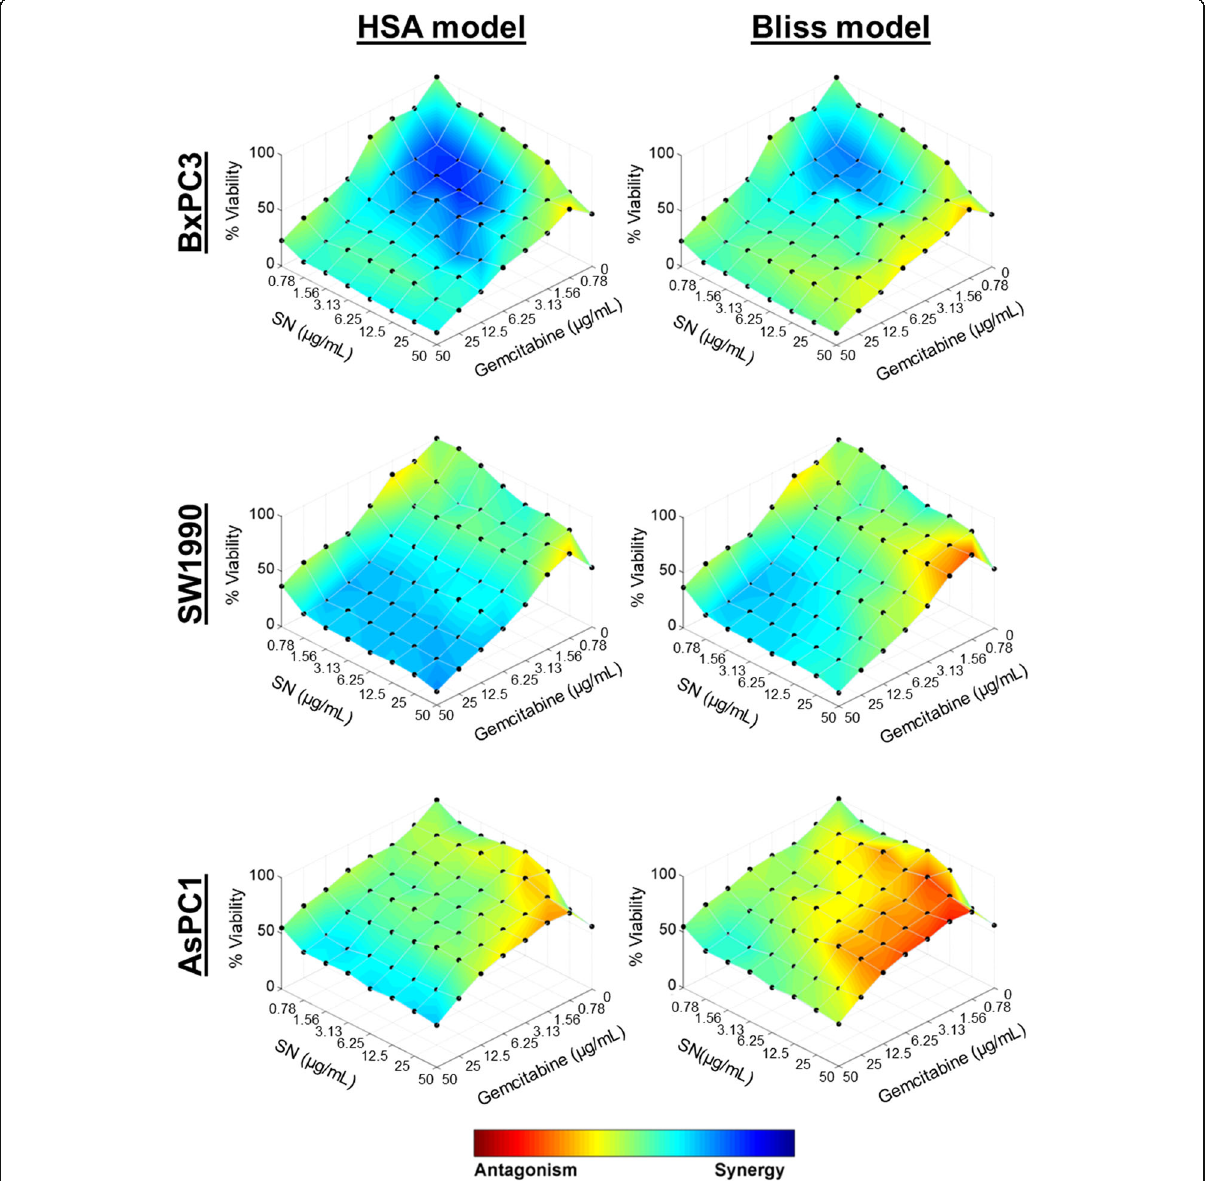
Fig. 2 Combinatory effects of SN extracts and gemcitabine on PDAC. The efficacy of drug combinations was assessed by treating cells in an 8 × 8 matrix combination of SN and gemcitabine that was 2-fold serially diluted from the highest concentration of 50 mg/L. Cell proliferation was evaluated in 96-well plates using MTT assay at 72 h after treatment. Combenefit software was used to generate and assess the dose-response surface curves and drug interaction effects following the HSA model and Bliss independence model as implemented in the software. The level of synergy (blue) or antagonism (red) at each combination was indicated by the color scale shown. The net Bliss interaction volumes of the matrix drug combination were calculated based on MacSynergy II program and graded accordingly. All the experiments were conducted in triplicate and performed